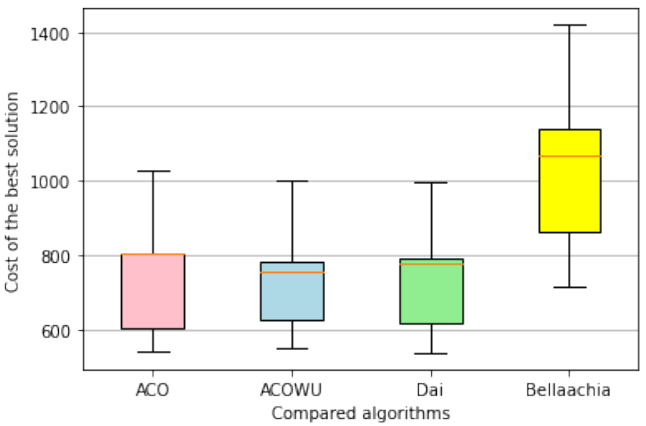
Figure 5. Results obtained in warehouse in terms of cost.